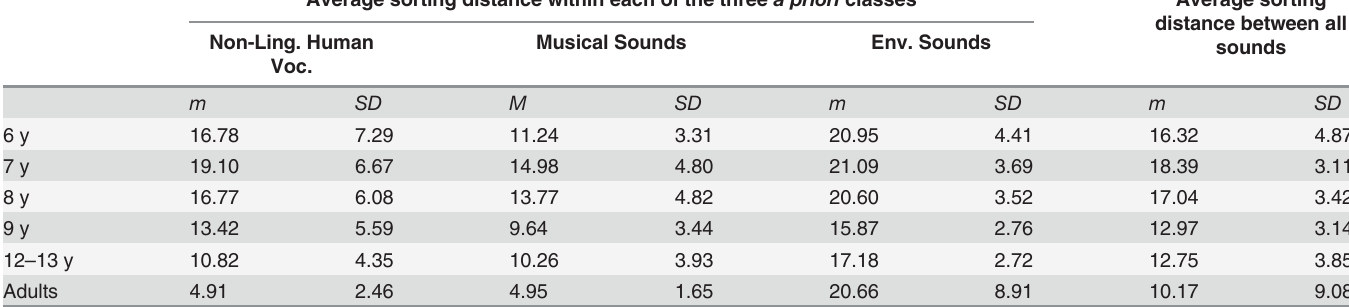
distance between all